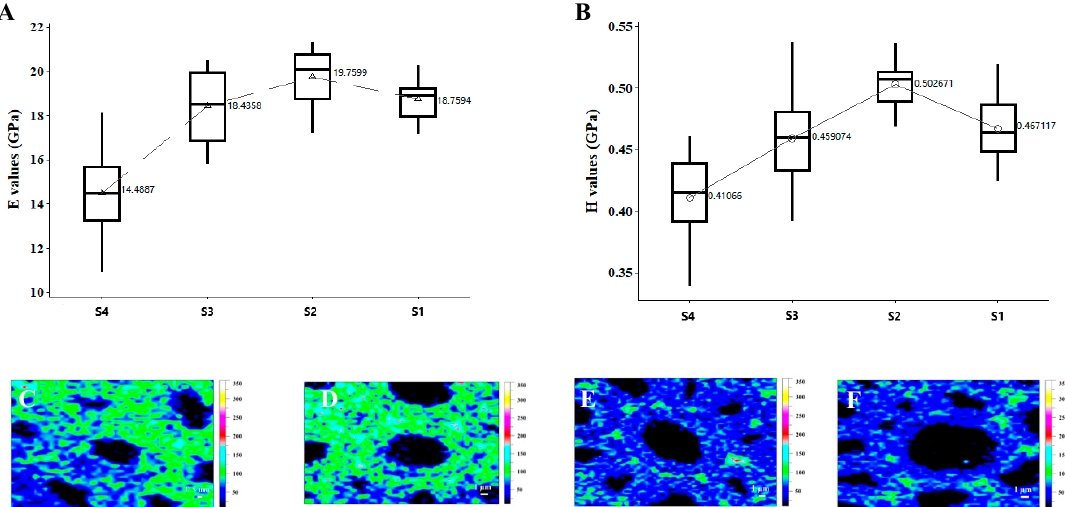
Figure 8. ( A ) Indentation modulus ( E ) values, determined by NI, of the secondary cell wall of elm wood. ( B ) Hardness ( H ) values, determined by NI, of the secondary cell wall of elm wood. Raman images calculated by integrating from 1720 to 1540 cm − 1 (lignin): ( C ) S4; ( D ) S3; ( E ) S2; ( F ) S1.